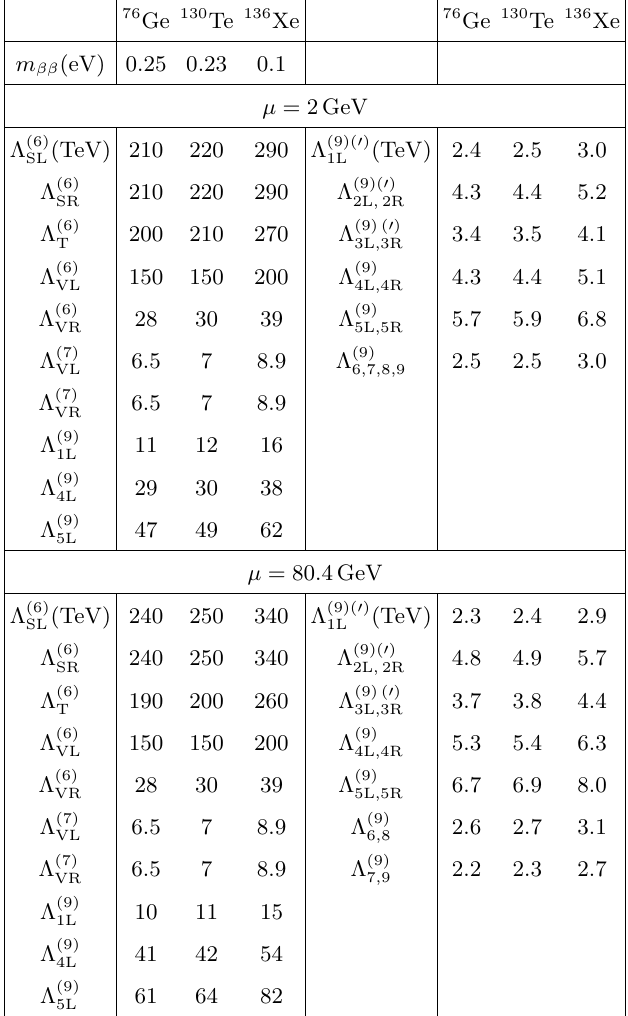
m (cid:12)(cid:12) and lower limits on the scales, (cid:3) ( d ) , related to i j j ( (cid:22) ) = ( v= (cid:3) ( d ) ) 3 for the dim-6, dim-7, and i i